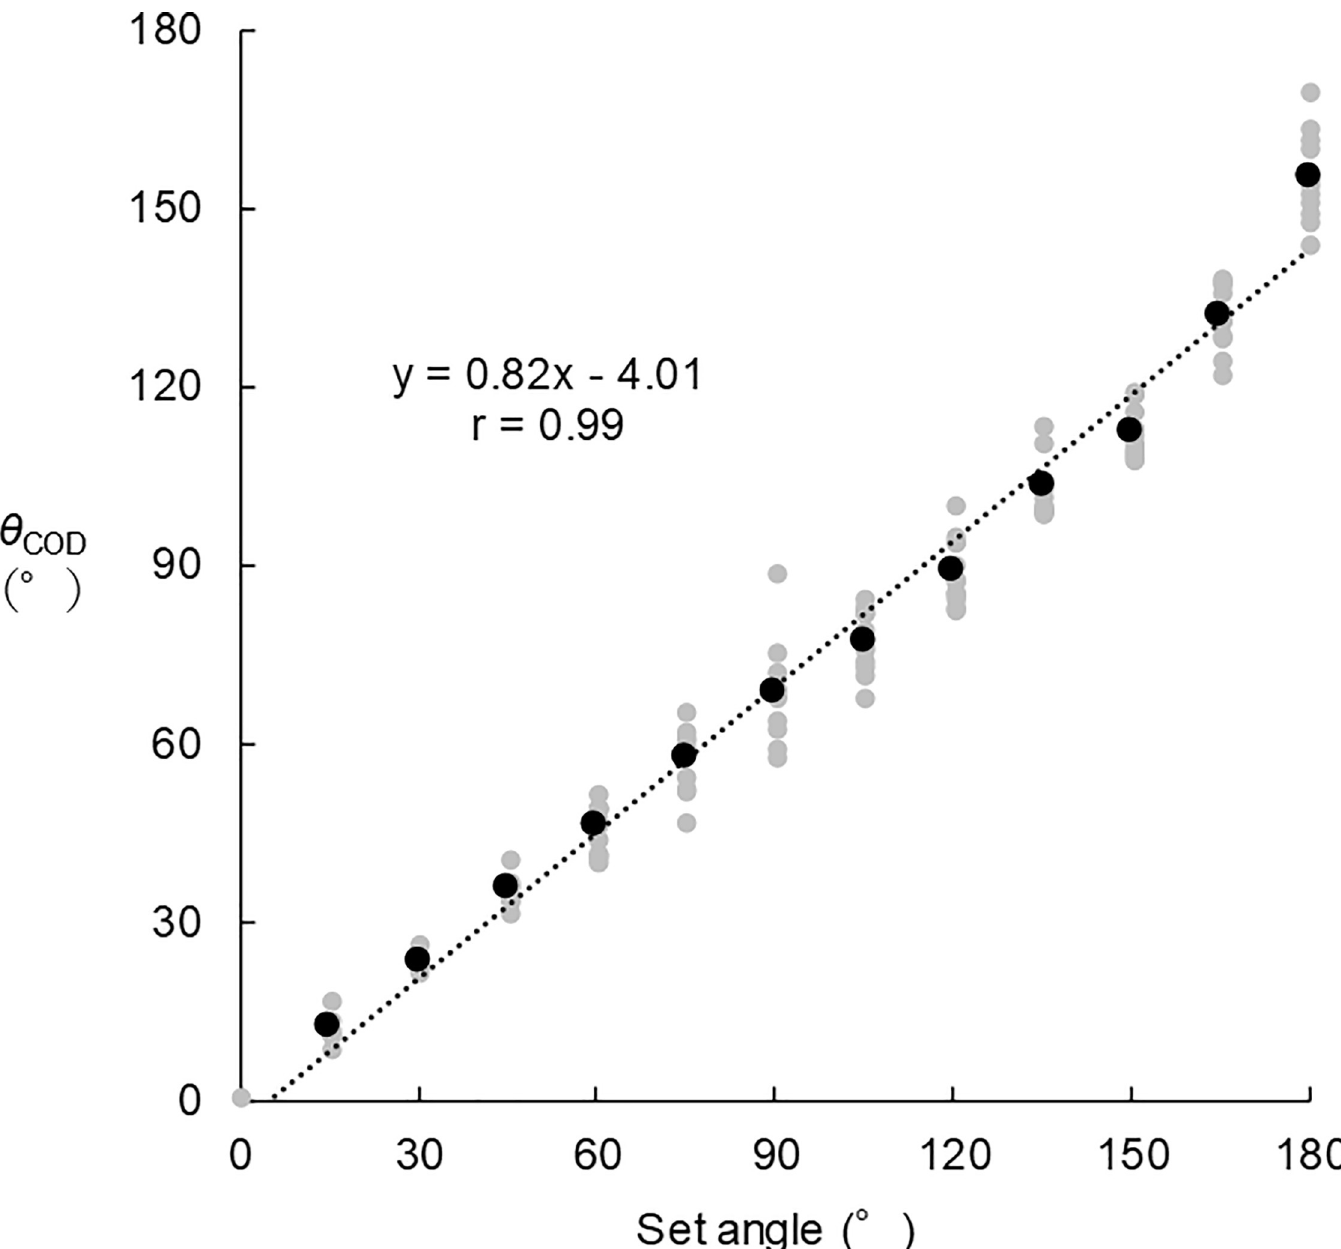
Fig 2. Relationship between θ COD and set angles. Black dotted plot indicates the mean value of each set angle. Grey dotted plots indicate individual’s data within each set angle. Dotted line indicates approximate line.